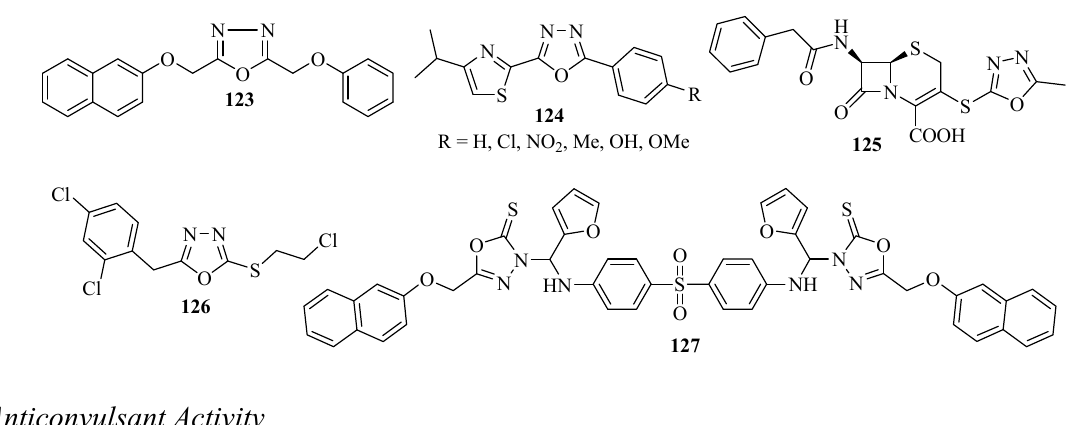
Figure 6. 1,3,4-Oxadiazoles with anti-mycobacterial activity.